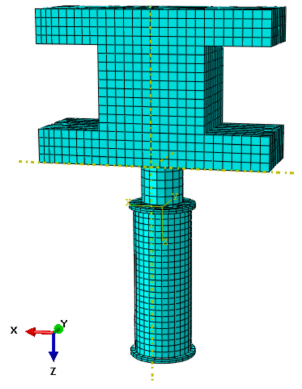
Figure 13. The finite element